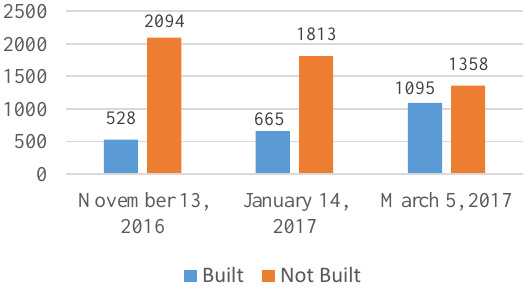
Figure 10. Detected number of building elements using the